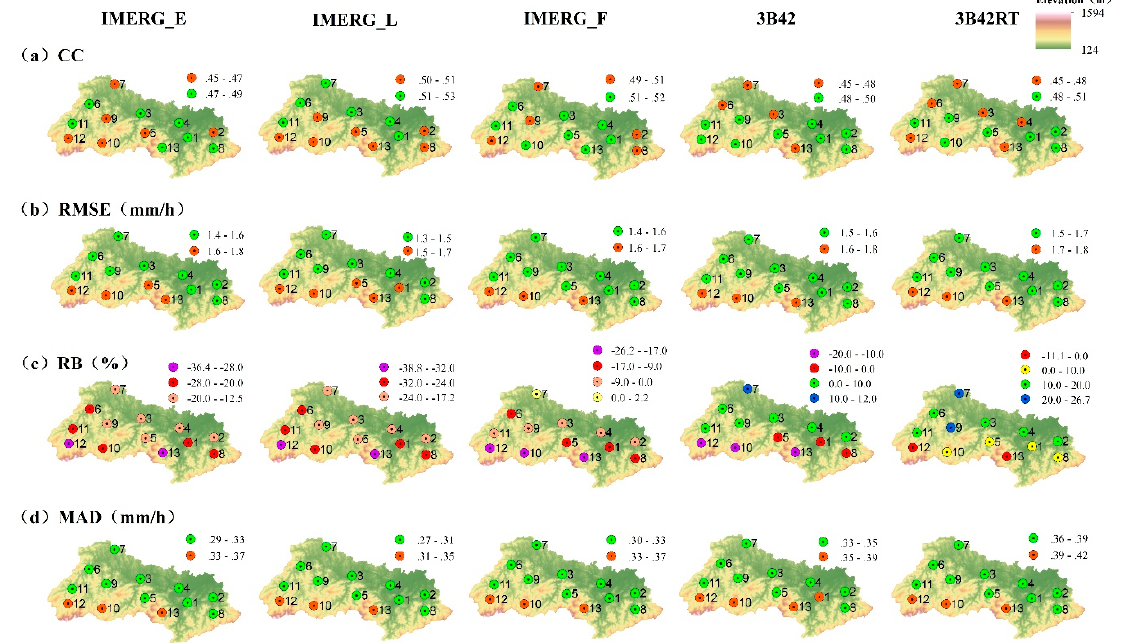
Figure 9. Spatial distribution of the continuous evaluation metrics (April to October) at hourly scale: ( a ) CC ; ( b ) RMSE ; ( c ) RB ; and ( d ) MAD .